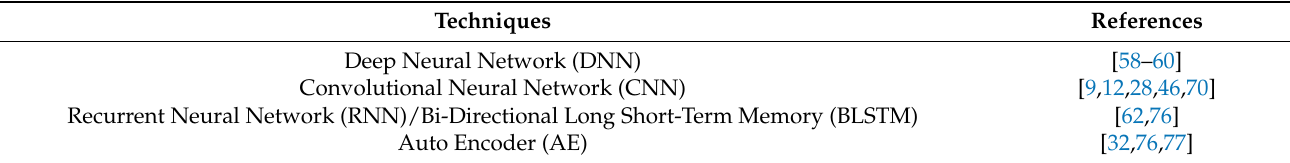
Table 6. Summary of deep learning techniques for sound classification.